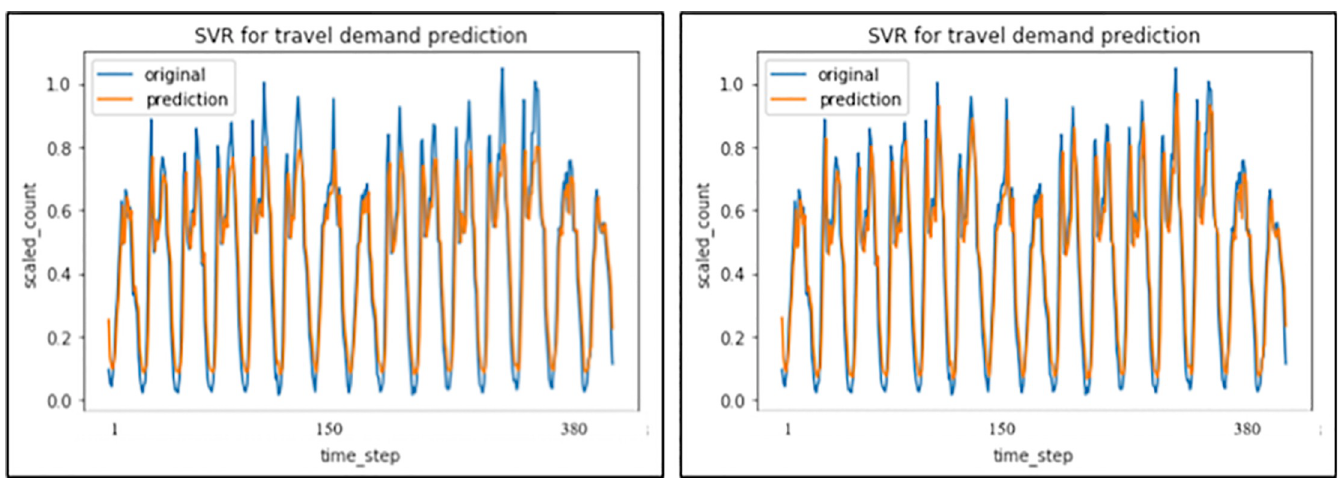
Fig 9. SVR with ‘rbf’ and ‘linear’ kernel prediction results.